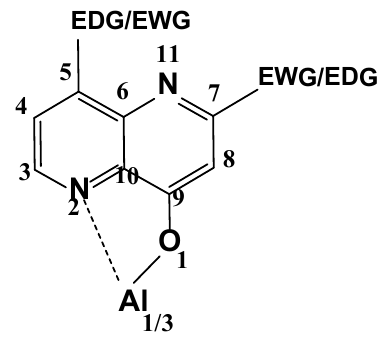
Figure 3: The ligand atom labels used in the text for the disubstituted AlND3 complexes considered in this study in Table 4 and Table S2(a-d) (for EDG and EWG labels are not shown).